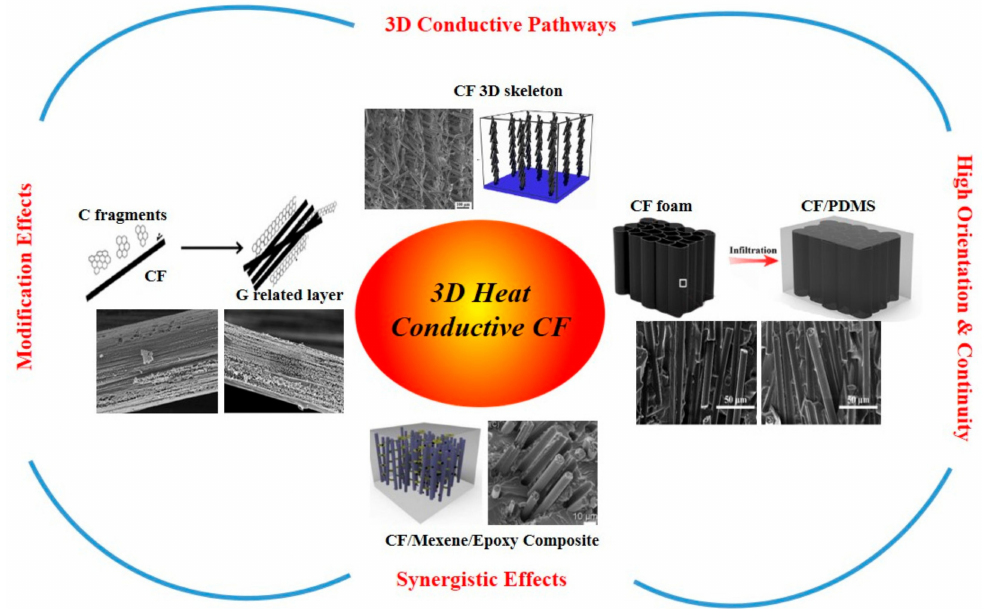
Figure 1. Overview of advantages of carbon fiber as a thermal conductive filler. Reproduced with permission from